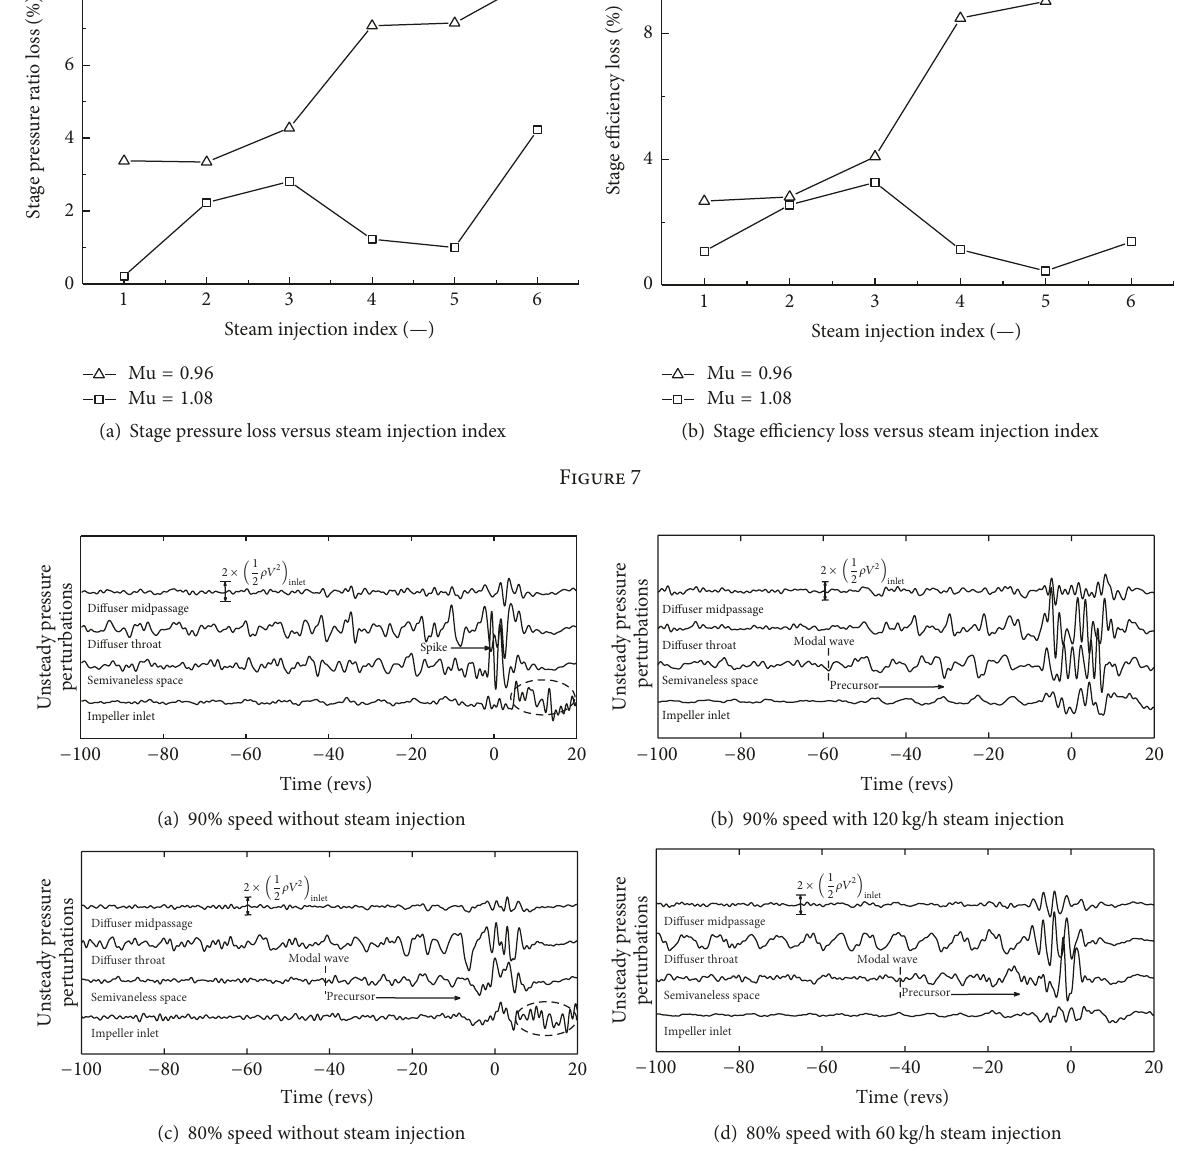
Figure 8: Pressure perturbation analysis for streamwise